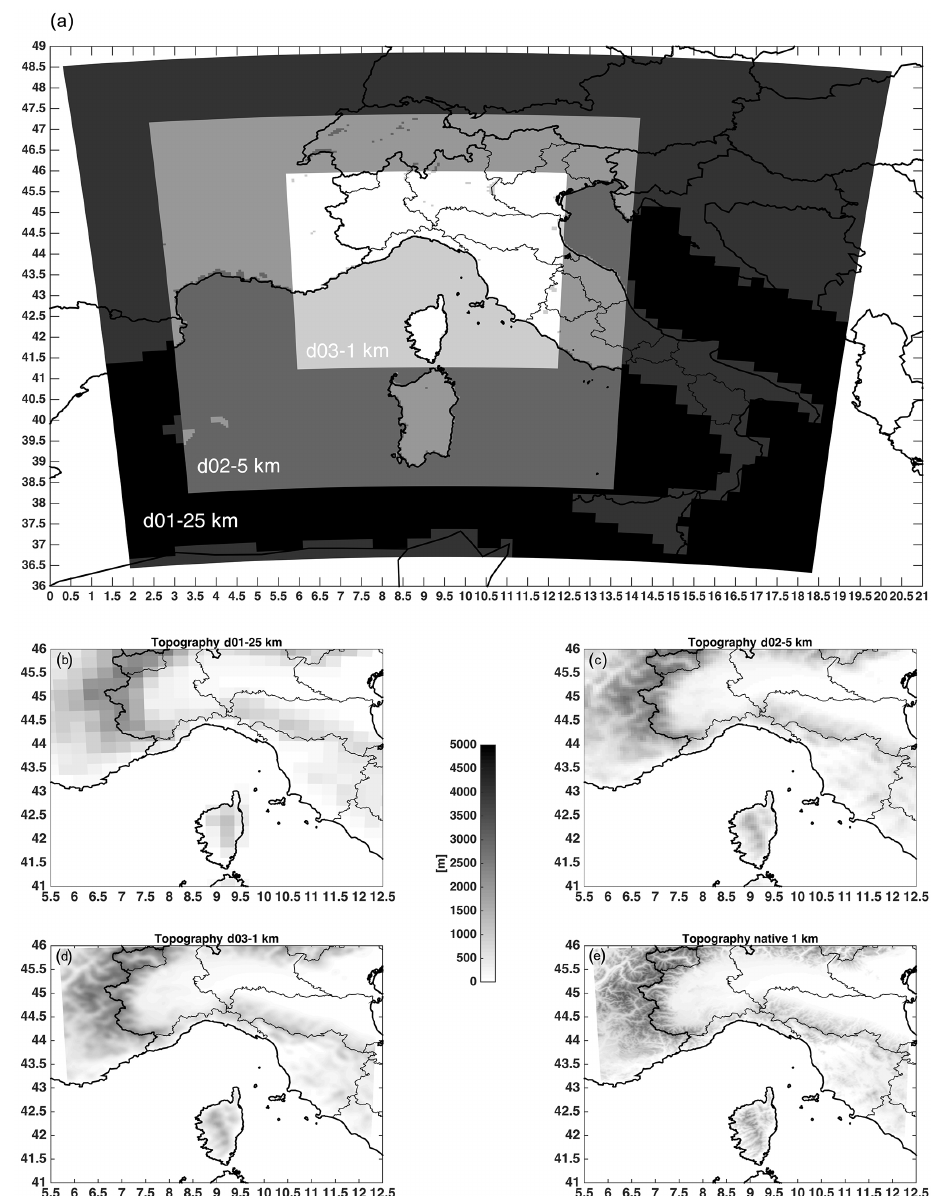
Figure 8. Panel (a) shows domains for the numerical simulations of the Genoa 1915 event, d01 ( (cid:49) = 25km), d02 ( (cid:49) = 5km) and d03 ( (cid:49) = 1km). Panels (b–e) compare the topography over the d03 area for d01, d02, d03 and native 1km grid